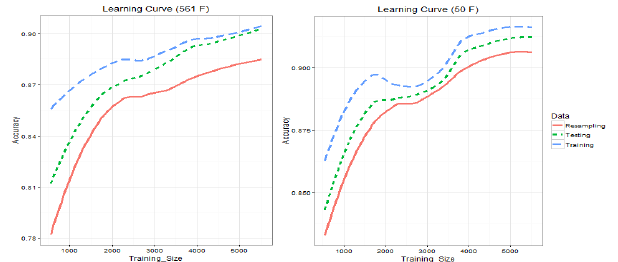
Figure. 2. Learning Curves of the SVM final models obtained: Before feature selection (Left side) and after feature selection (Right side). TABLE 4: Confusion Matrix of SVM on Test data TABLE 4: Confusion Matrix of SVM on Test